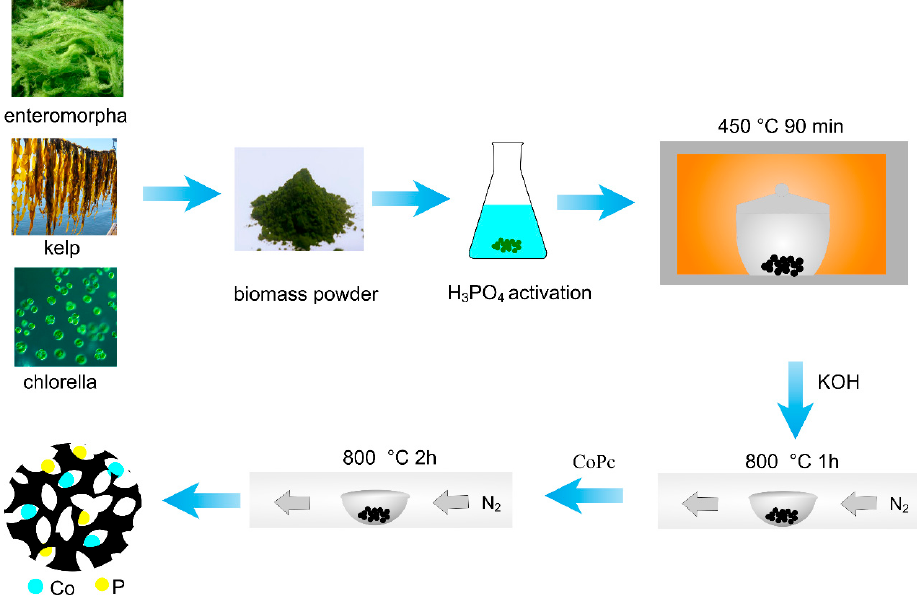
Figure 11. Schematic presentation of the synthesis procedure for three algal biomass derived carbons doped with cobalt.